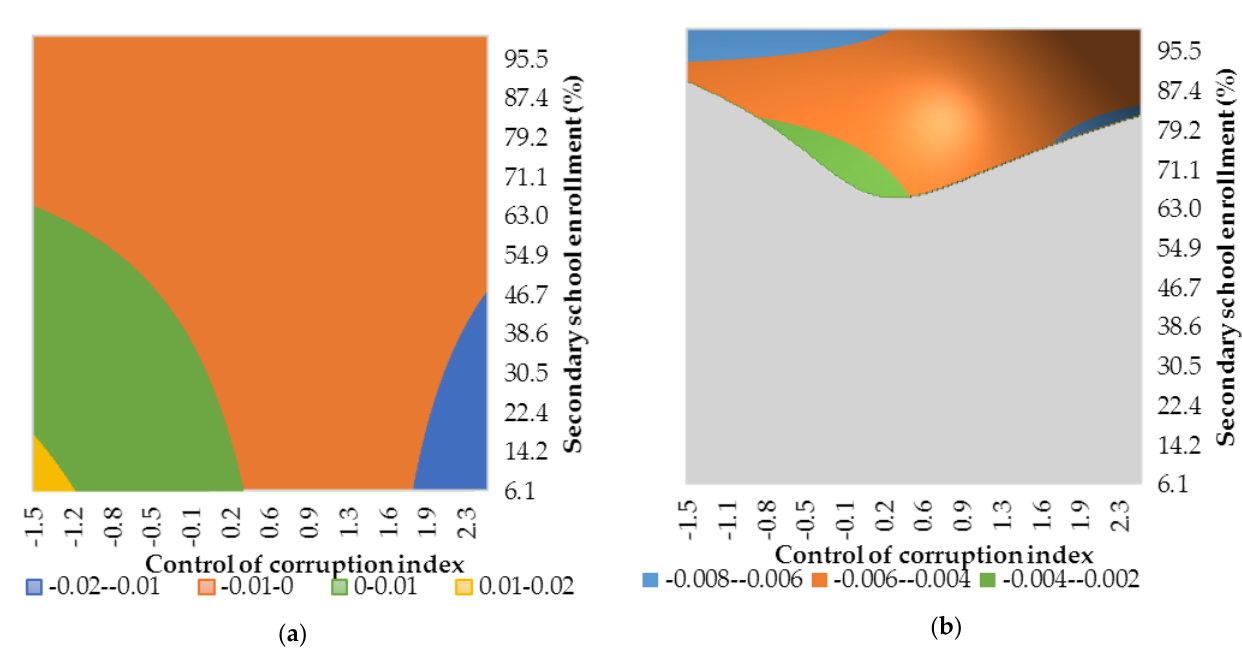
Figure A1. Conditional effect of financialisation on growth based on Est. 1 in Table A2. ( a ) Estimated conditional slope coefficient over the whole range of observed values for institutional quality and development level. ( b ) Estimated statistically significant conditional slope coefficient. Gray represents a combination of institutional quality and development level for which effect of financialisation on growth is statistically insignificant. Source: authors’ contributions.